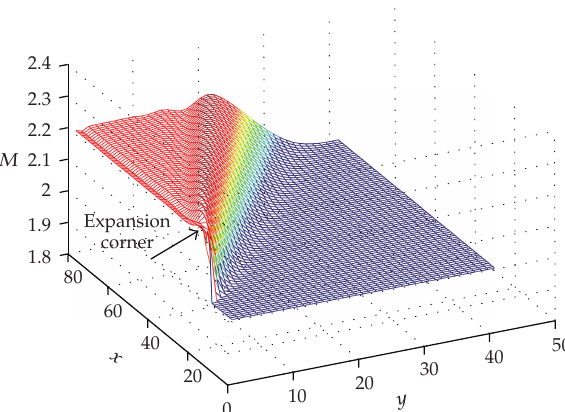
Figure 14: Mach number in the expansion corner.